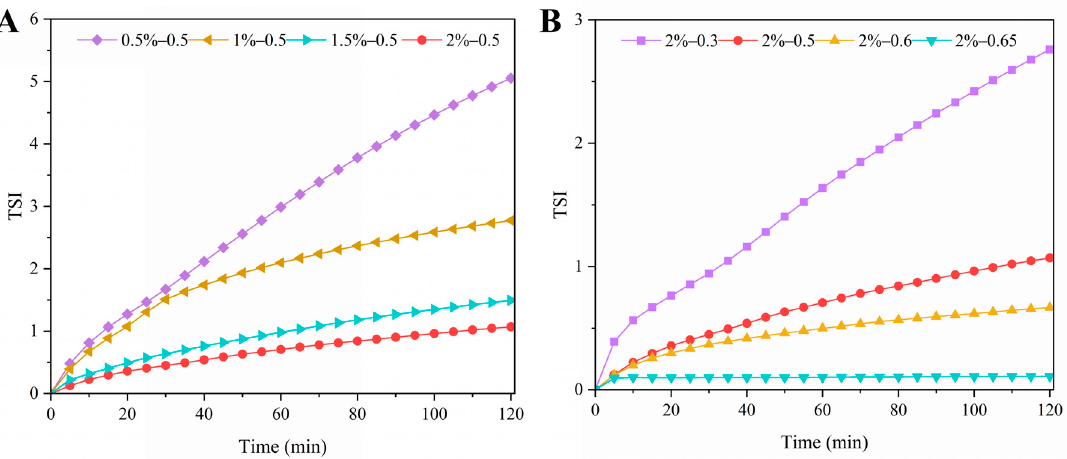
Figure 8. TSI of Pickering emulsions stabilized with different c (0.5–2 wt%) of the LF–FD complexes at different φ (0.3–0.65): ( A ) φ = 0.5; ( B ) c = 2 wt%.